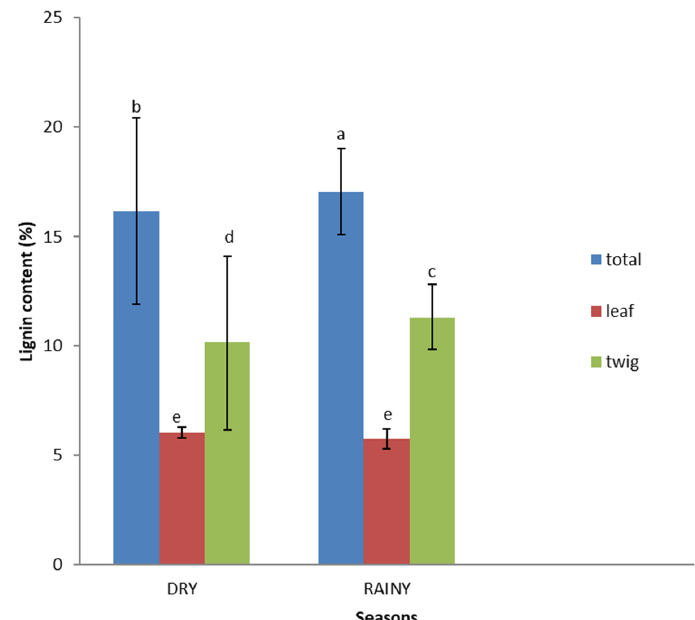
Figure 1b. Lignin Content in the litter standing crop of bamboo stands at the peak of seasons in a regenerating forest, Ile-Ife *Vertical bars of the same alphabet in a month are not significantly (p > 0.05) different using Duncan Multiple Range Test